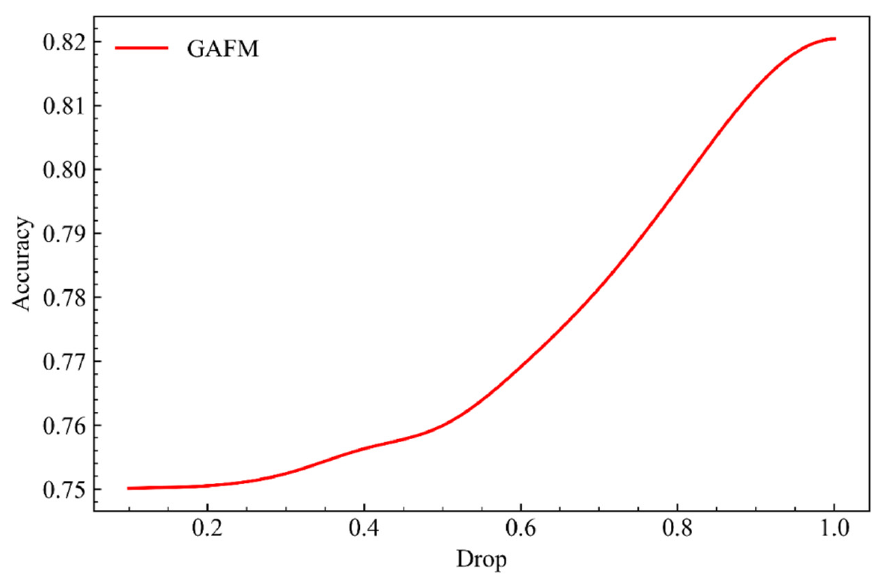
Figure 4. Prediction accuracy of GAFM under the influence of the drop value. increase of parameter g, the accuracy rate of the model on dataset 1 shows a rapid but slightly fluctuating increase.